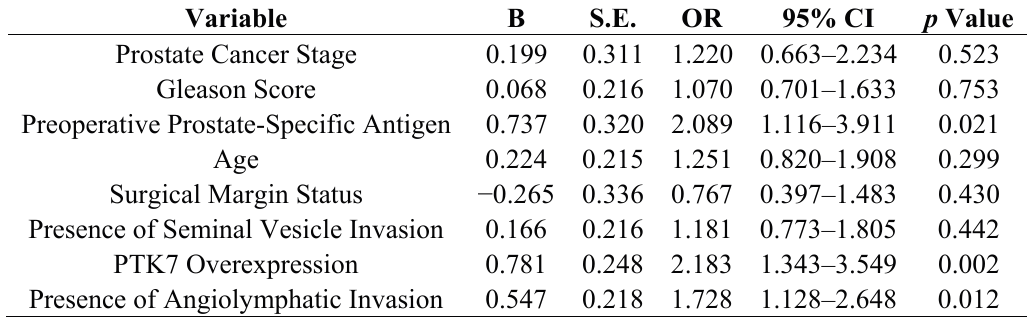
Table 2. Factors predictive of lymph node metastasis in the univariable analysis.